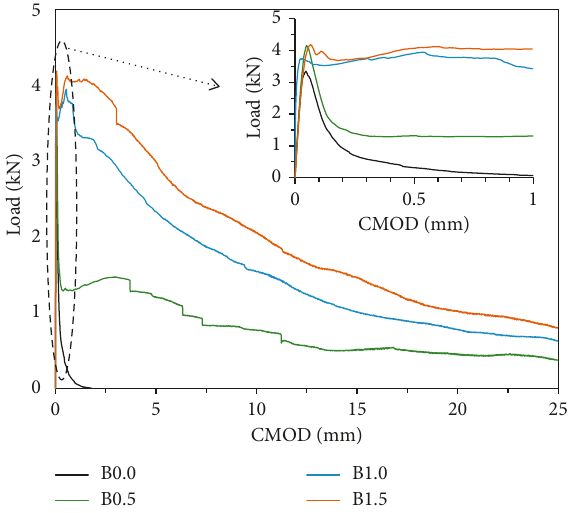
Figure 5: Load-displacement curves of the tested prisms. Figure 6: Load-CMOD curves of the tested